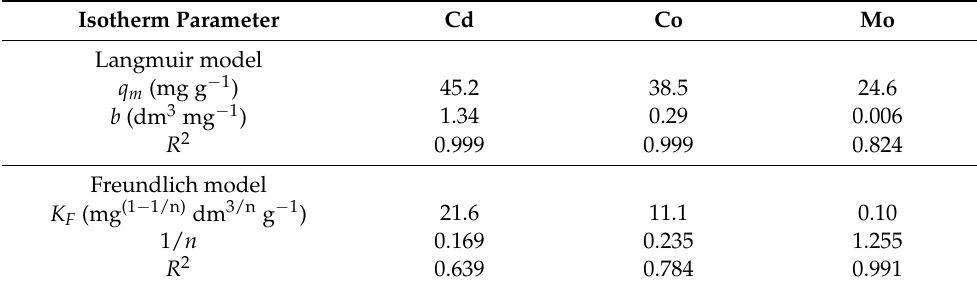
Table 3. Freundlich and Langmuir isotherm parameters for the uptake of Cd 2+ , Co 2+ and MoO 42 − Table 2. Metal ion removal, pH of solution and dissolution of constituents of CCF after 3 weeks. from aqueous solution by crushed concrete fines.